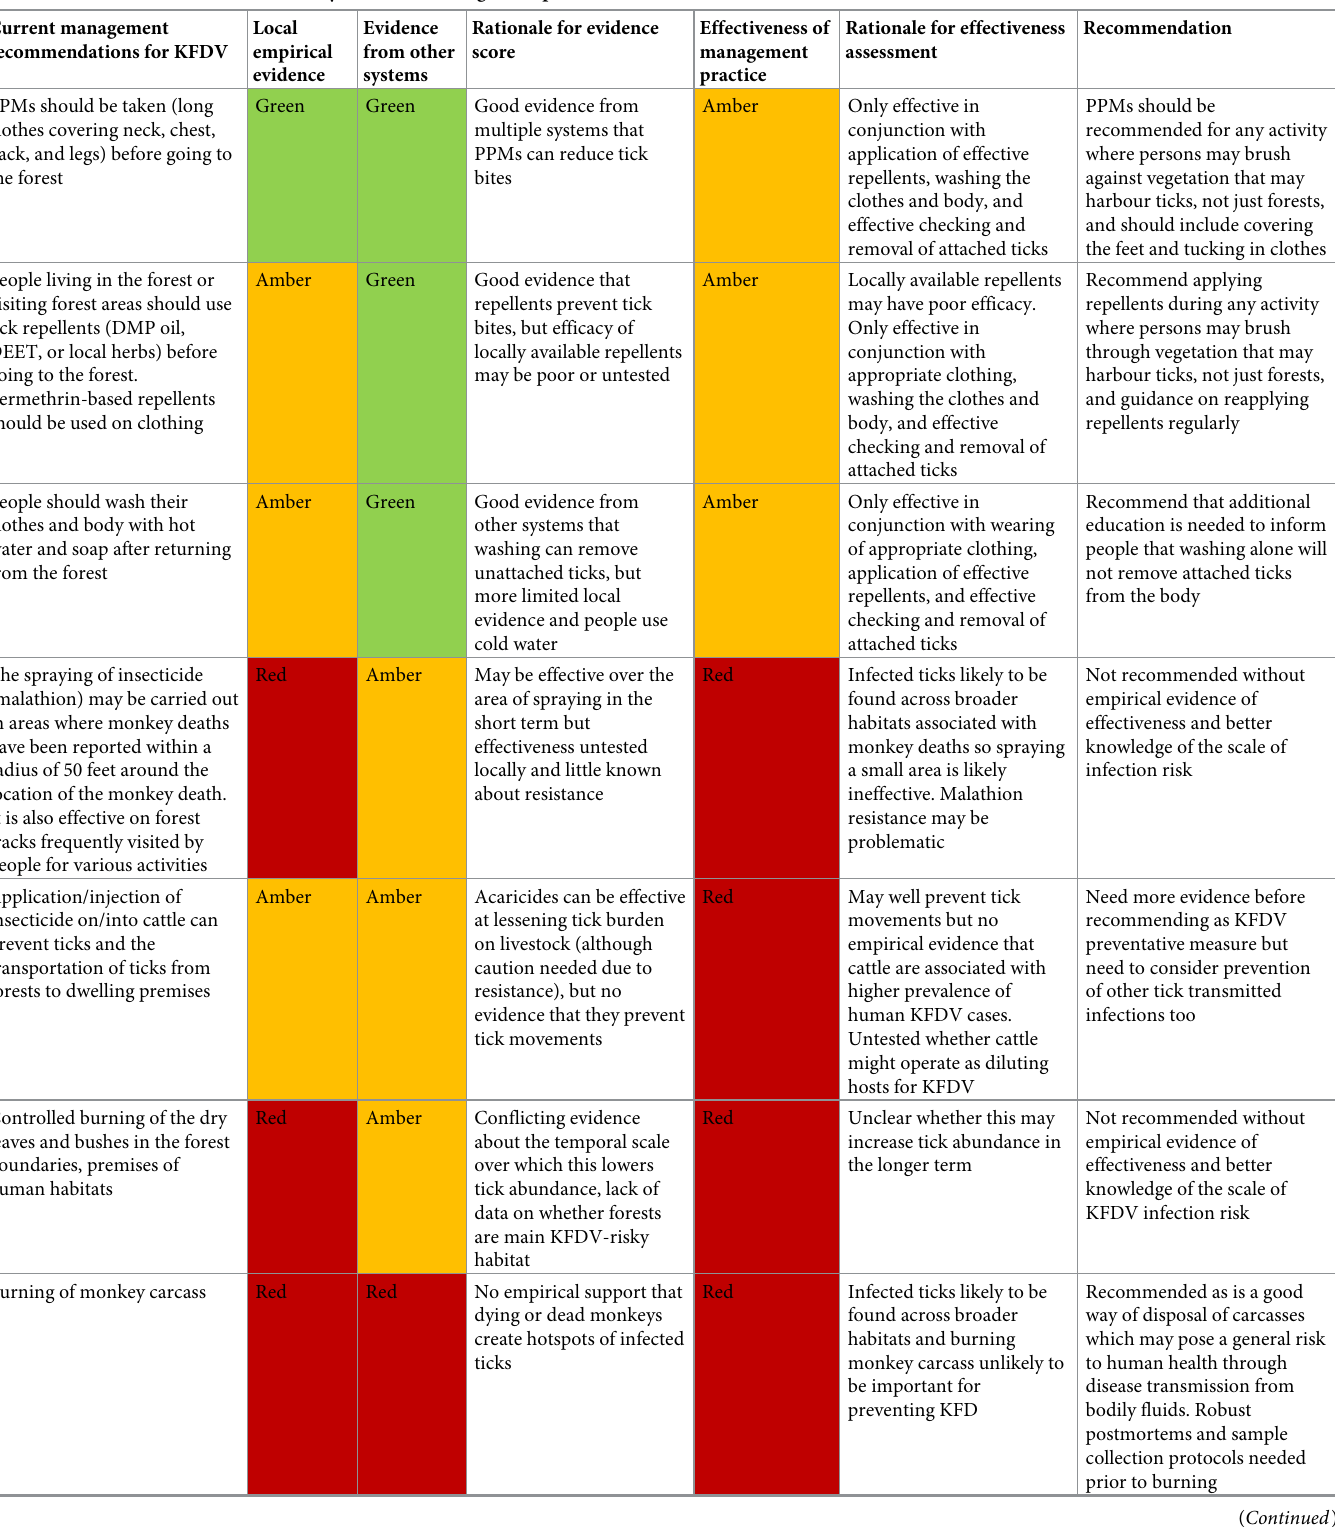
Table 2. Overall assessment of the validity of current management practices for